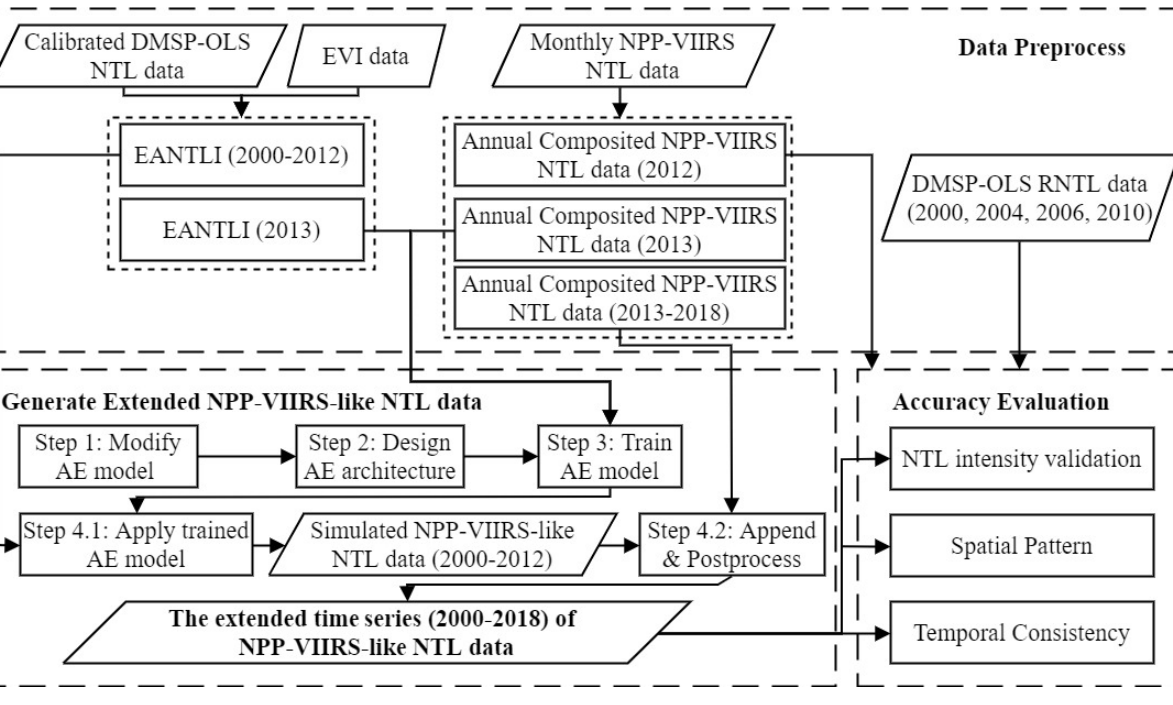
Figure 2. Flow chart of the generation of NPP-VIIRS-like NTL data.